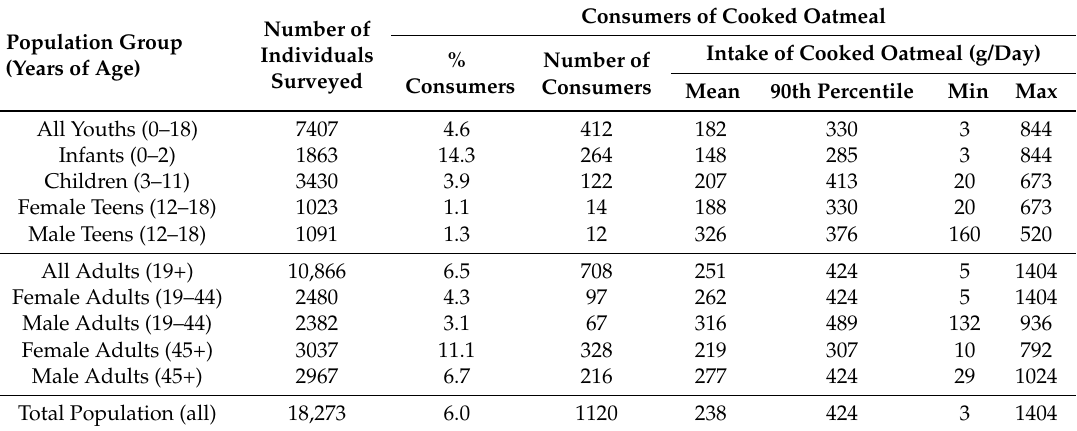
Table 2. Total intakes of cooked oatmeal from all eating occasions among consumers of cooked oatmeal (data from Day 1 of the 2009–2012